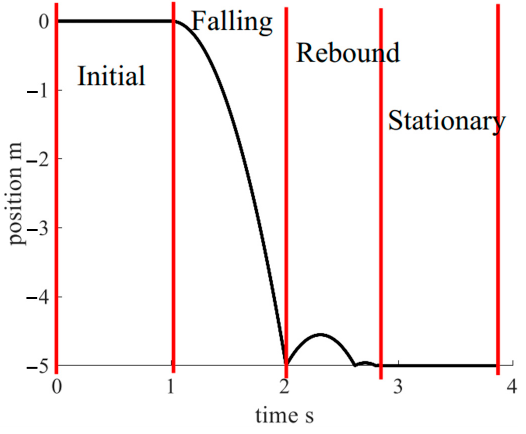
Figure 8. Falling process decomposition.